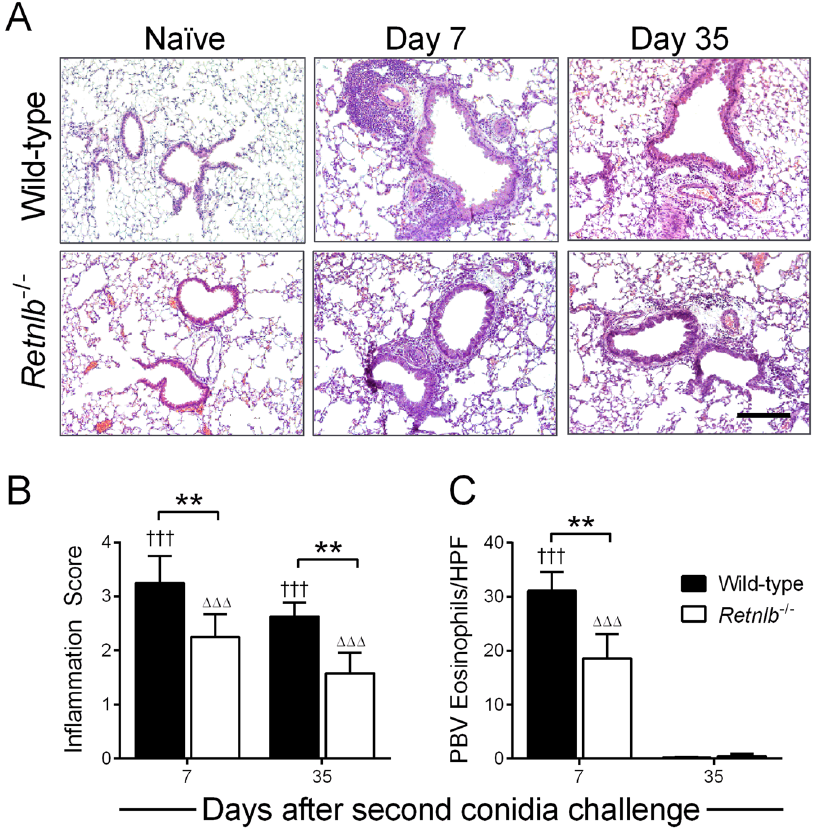
Figure 3. RELM- β promotes peribronchovascular inflammation. Peribronchovascular inflammation was highest at early time points and gradually decreased over time in both genotypes compared to naïve controls ( A ), and Retnlb − / − mice had less tissue inflammation compared to WT ( B ). Tissue eosinophils were lower in KO mice compared to WT ( C ). Scale bar = 200 µ m and applicable to all photo micrographs. Naïve mice in each genotype were scored 0 and did not contain tissue eosinophils. Data are represented as the mean and SD of n = 4–7 mice/group in one representative study of two independent studies. Data at each time point were compared by two-way ANOVA with Dunnett’s and Sidak’s multiple comparisons test to their naïve controls († and Δ ), and between genotypes ( * ) respectively. One, two, and three symbols represent P < 0.05, P < 0.01, and P < 0.001 correspondingly. HPF – high power